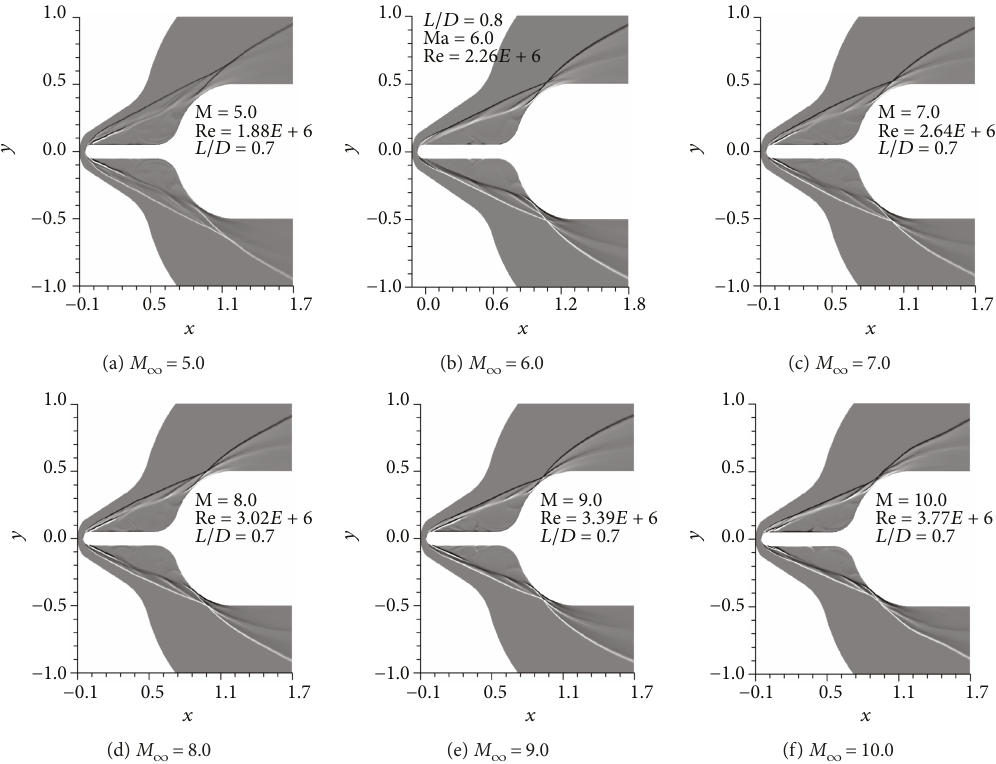
Figure 11: Flow fi eld density gradient in y direction of spiked blunt bodies with the sideward sonic jet. Spike length L/D = 0.7.